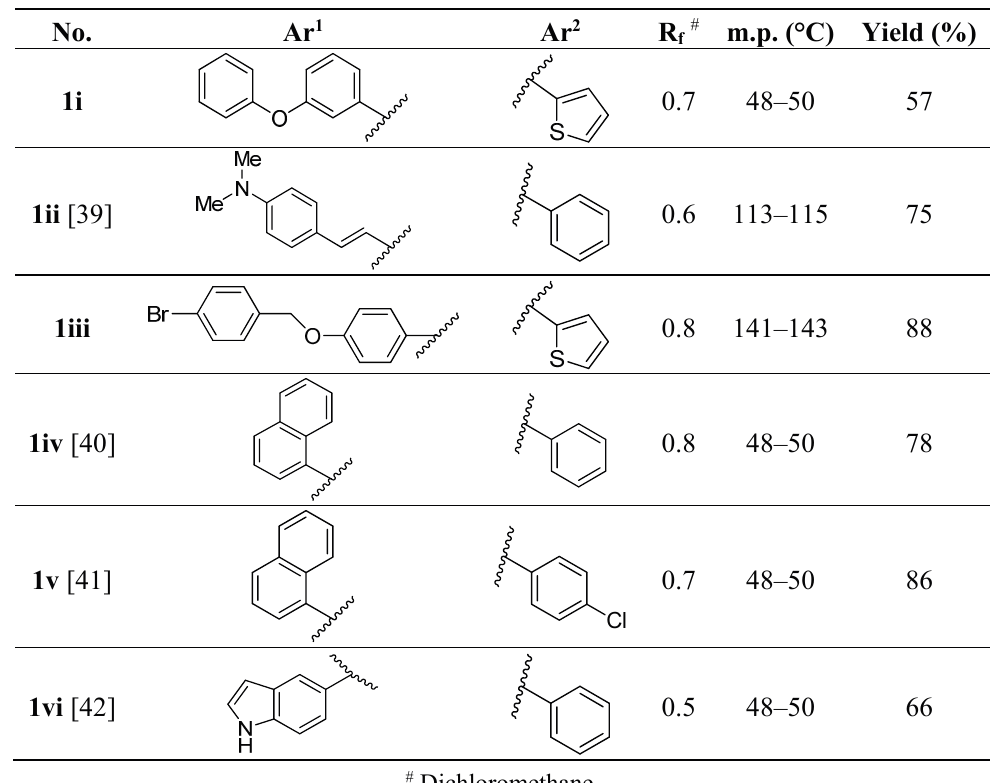
Table 1. Chemical structures, physicochemical and reaction data of chalcones 1i – 1vi